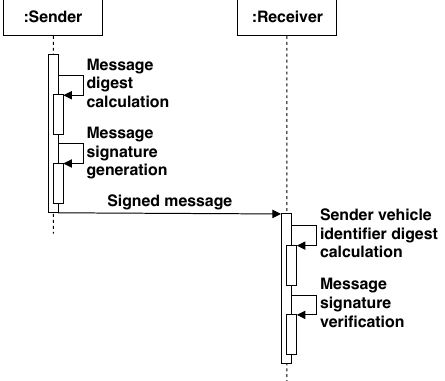
Figure 4. Sequence diagram of the Sign-Verify process in the CSS (and ACSS)